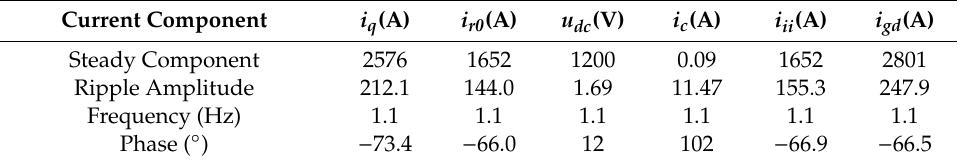
Table 3. Ripple component of